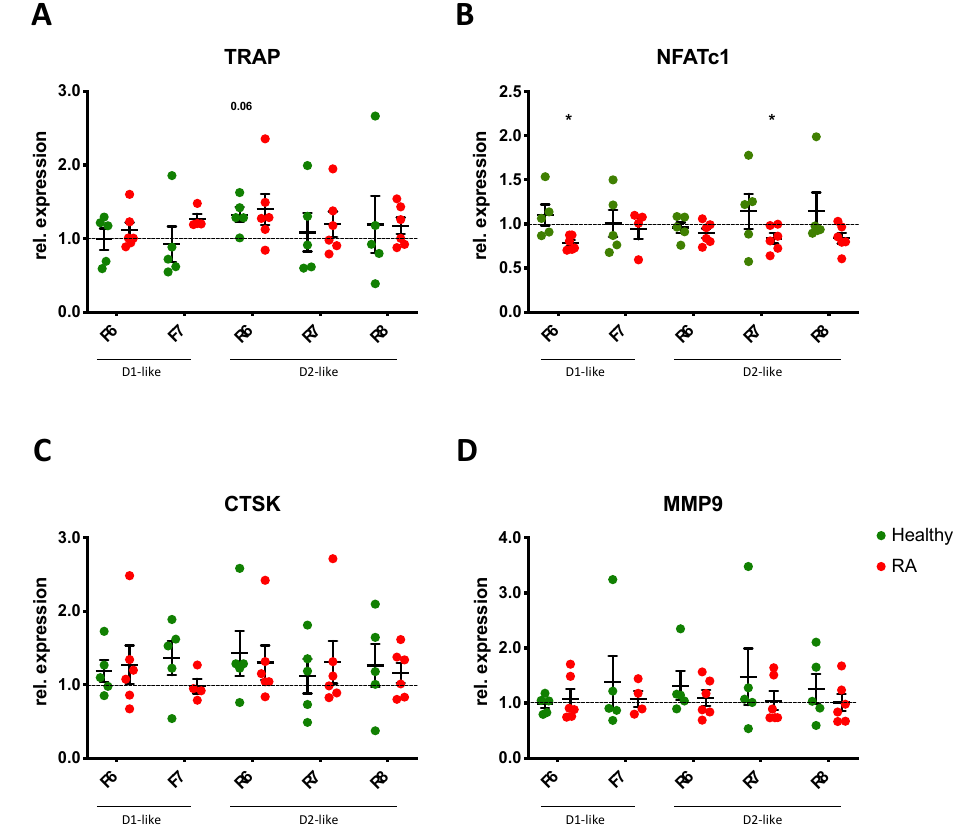
Figure 8. DR stimulation does not alter gene expression of OC markers. Expression of tartrate resistant phosphatase (TRAP, ( A )), nuclear factor of activated T-cells, cytoplasmic 1 (NFATc1, ( B )), cathepsin K (CTSK, ( C )) and matrix metalloprotease 9 (MMP9, ( D )) were analyzed by real-time PCR in PBMCs of healthy controls (green dots) and RA patients (red dots) cultured with OC differentiation medium for 14 days in the presence or not of DR agonists. Values are normalized to GAPDH expression as reference gene and presented as relative expression to control without DR agonist. HC n = 5, RA n = 4–6. F = Fenoldopam; R = Ropinirole; 6 = 10 − 6 M; 7 = 10 − 7 M; 8 = 10 − 8 M. Single dots represent mean values of duplicates for individual patients. *= p < 0.05 calculated by Wilcoxon matched pairs signed rank test compared to untreated control.